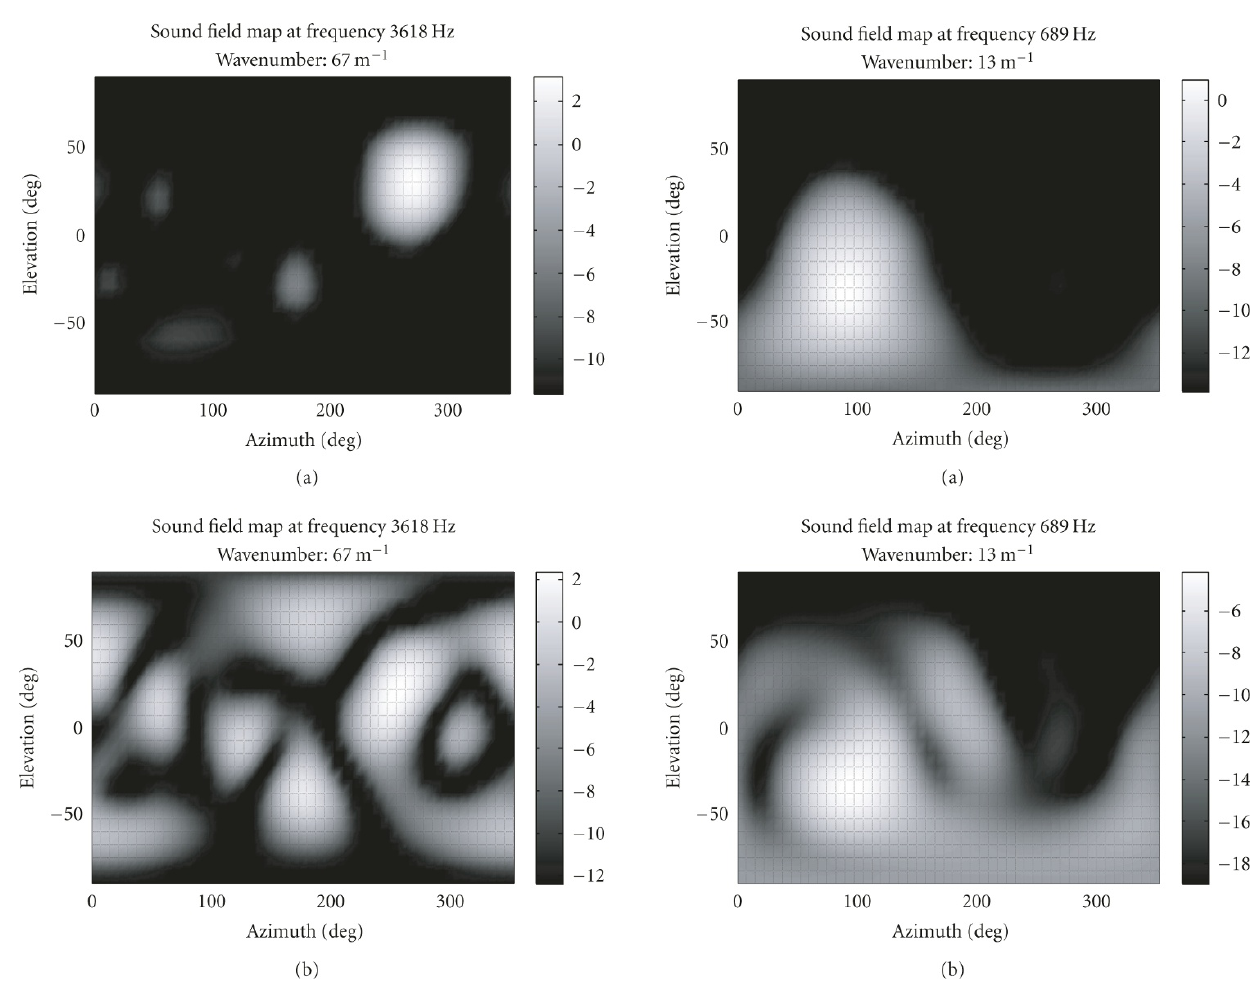
Figure 9: Sound field map obtained with measured data (mean po- sition error of 5mm) with regularized tap vectors (a) or nonregu- larized (b) tap vectors at frequency 3618 Hz for a source with coor- dinates [ r = 1m, az = 270dg, el = 31dg].